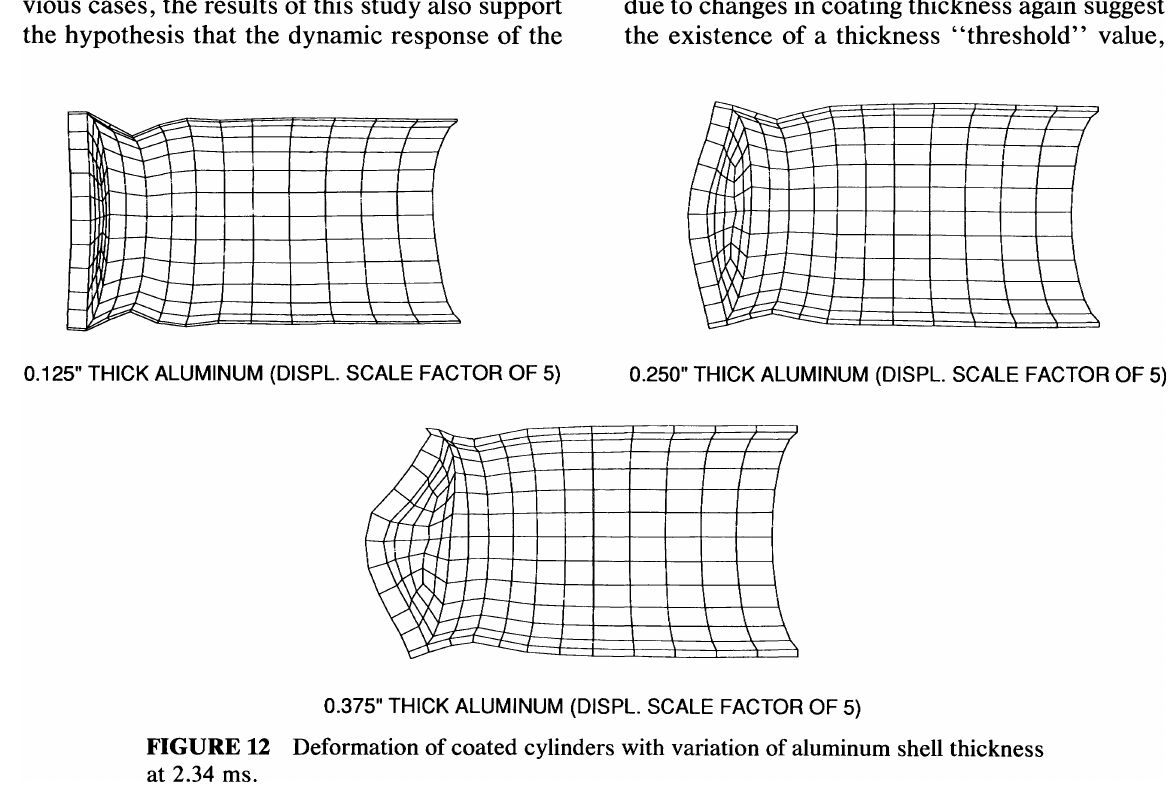
FIGURE 11 Effective plastic strain at position C3 for coated cylinders with variation of aluminum shell thickness.